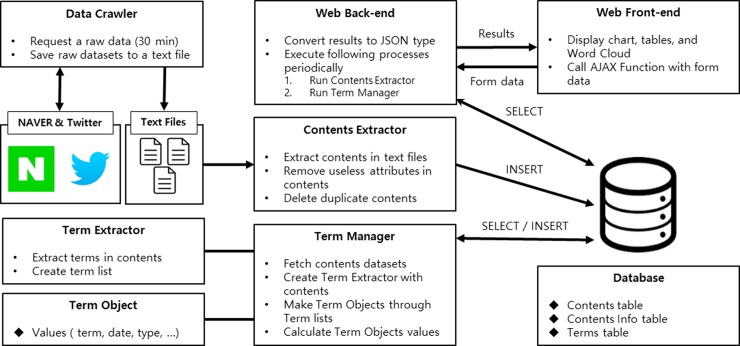
System architecture.